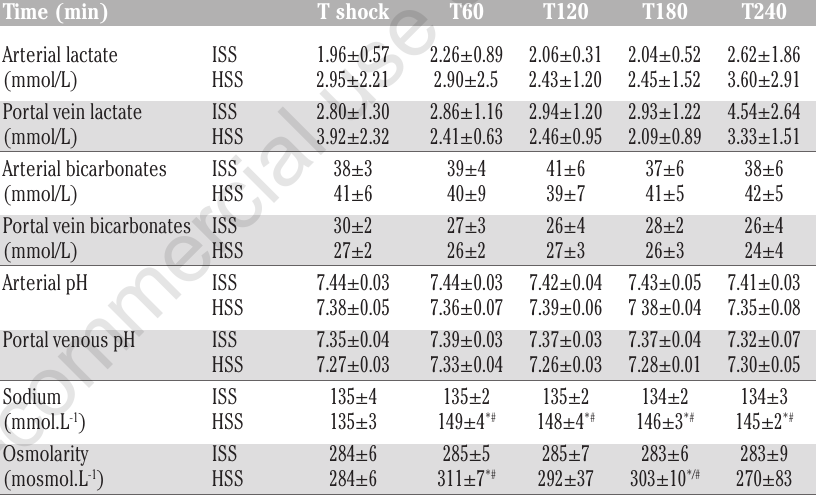
Table 3. Acid-base balance. After induction of peritonitis, septic shock took place at T shock, when pigs were resuscitated during 240 min either with (HSS-HES)